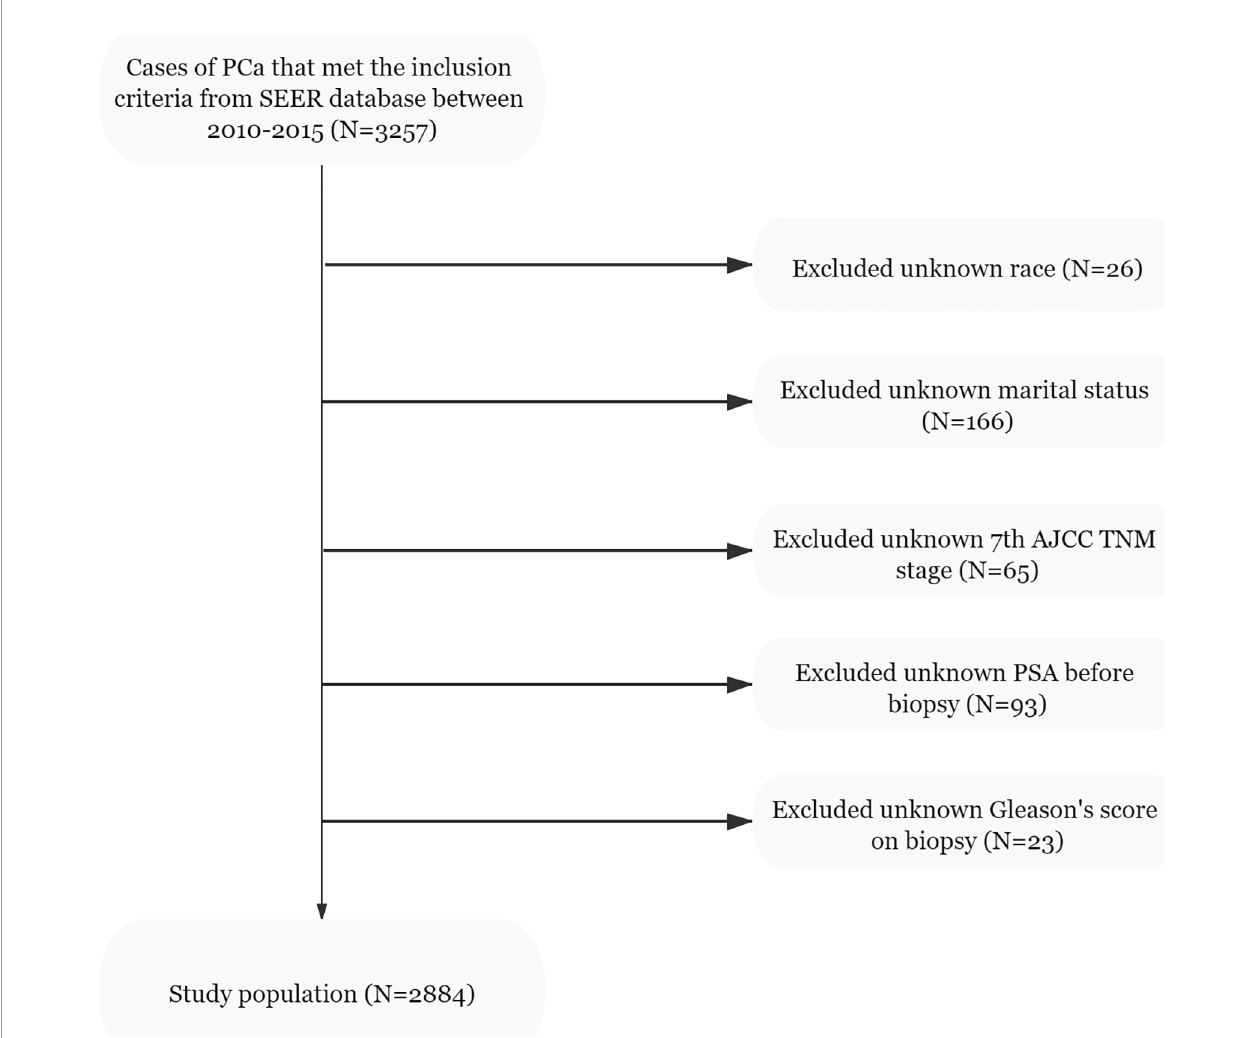
FIGURE 1 | Flowchart of the study population selected from the SEER database, based on the inclusion and exclusion criteria outlined above; 2,884 patients were included in this